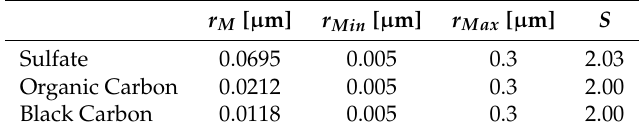
Table 4. Lognormal size distribution parameters for dry OC, BC, and sulfate.